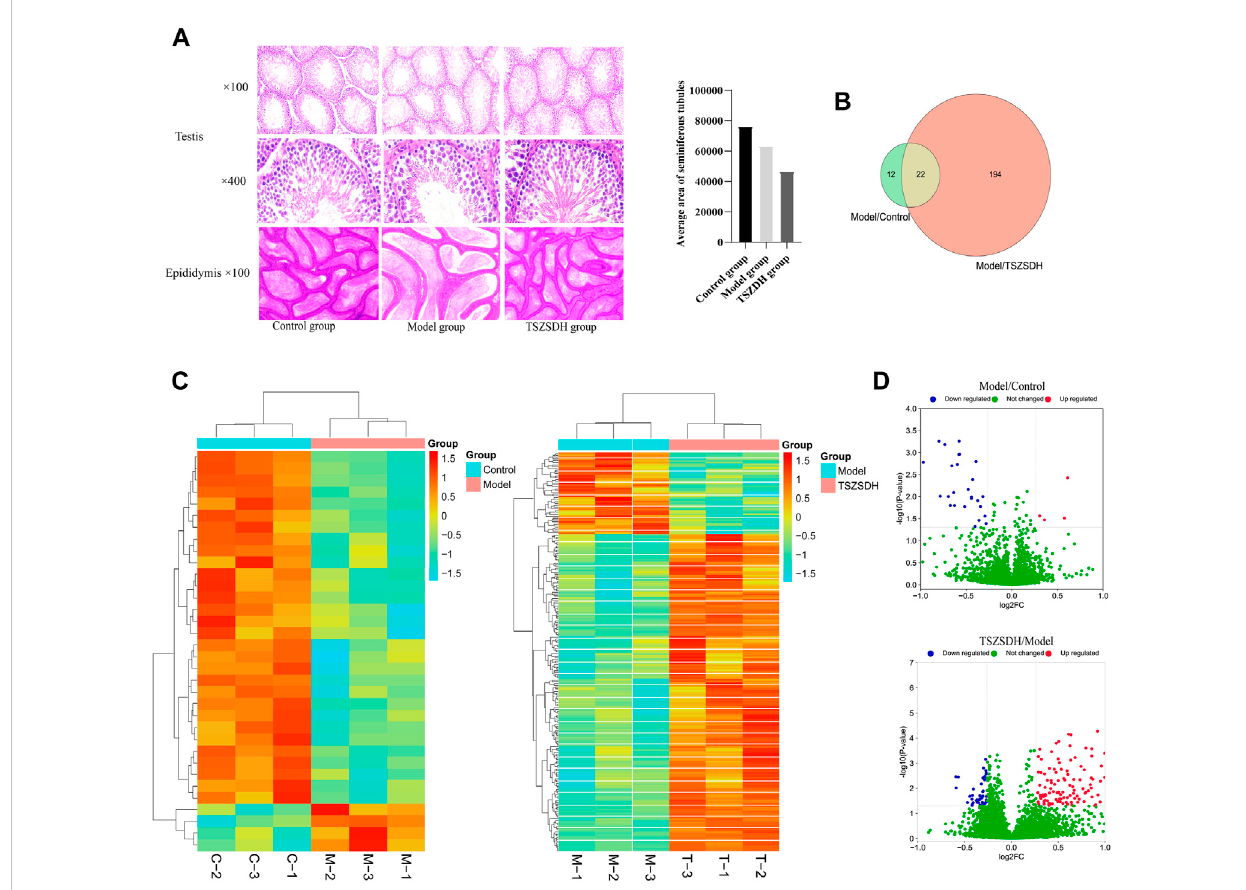
FIGURE 2 (A) Testicular and epididymal tissues were stained with hematoxylin and eosin (HE) and observed under a light microscope at ×100 and ×400 magni fi cations. Control group (Control); Tripterygium wilfordii multiglycosides-induced reproductive injury model group (Model); Cuscutae semen – Rehmannia Glutinosa treatment group (TSZSDH). (B) Results of Tandem Mass Tag (TMT) protein labeling experiments. The green part represents the results of differential protein labeling between the model and control groups; the red part represents the result of the differential protein labeling between the TSZSDH and model groups, and the crossed part in yellow represents the overlapping portion. (C) Clustering heat map comparing the model group with the control group, and the TSZSDH group with the model group. Upregulated protein expression is indicated in red, while downregulated protein expression is indicated in blue. (D) Volcano plot comparing the model and control groups, and the TSZSDH and model groups. Thelog2fold-change (FC)valueistheabscissaand the-Log10( p -value) istheordinate.UPRed indicates thatdifferentiallyexpressedproteins are upregulated, while blue indicates downregulated proteins, and green indicates proteins whose expression was not signi fi cantly